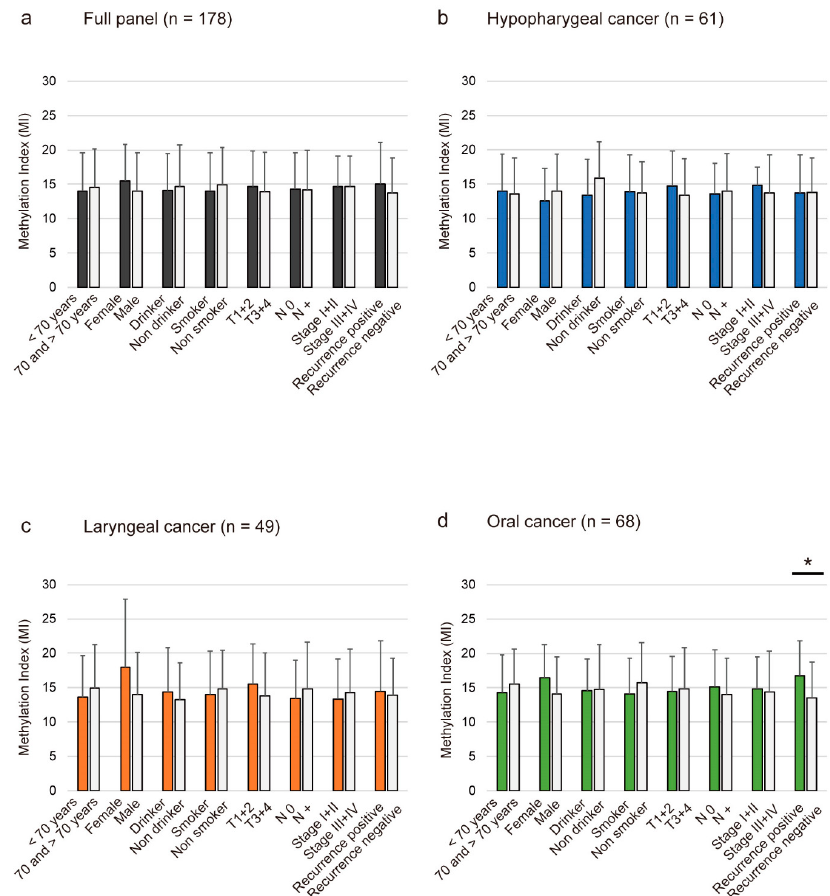
Figure 2. Association between methylation indices (MI) and selected clinical parameters. The mean MI for the various groups was compared using Student's t -tests. Shown are the associations between MI and selected epidemiologic and clinical characteristics in ( A ) full panel; ( B ) hypopharyngeal cancer; ( C ) laryngeal cancer; and ( D ) oral cavity cancer. Statistical comparisons between the groups are represented as a mean with standard deviation. A probability of <0.05 (* p < 0.05) was considered to represent a statistically significant difference.